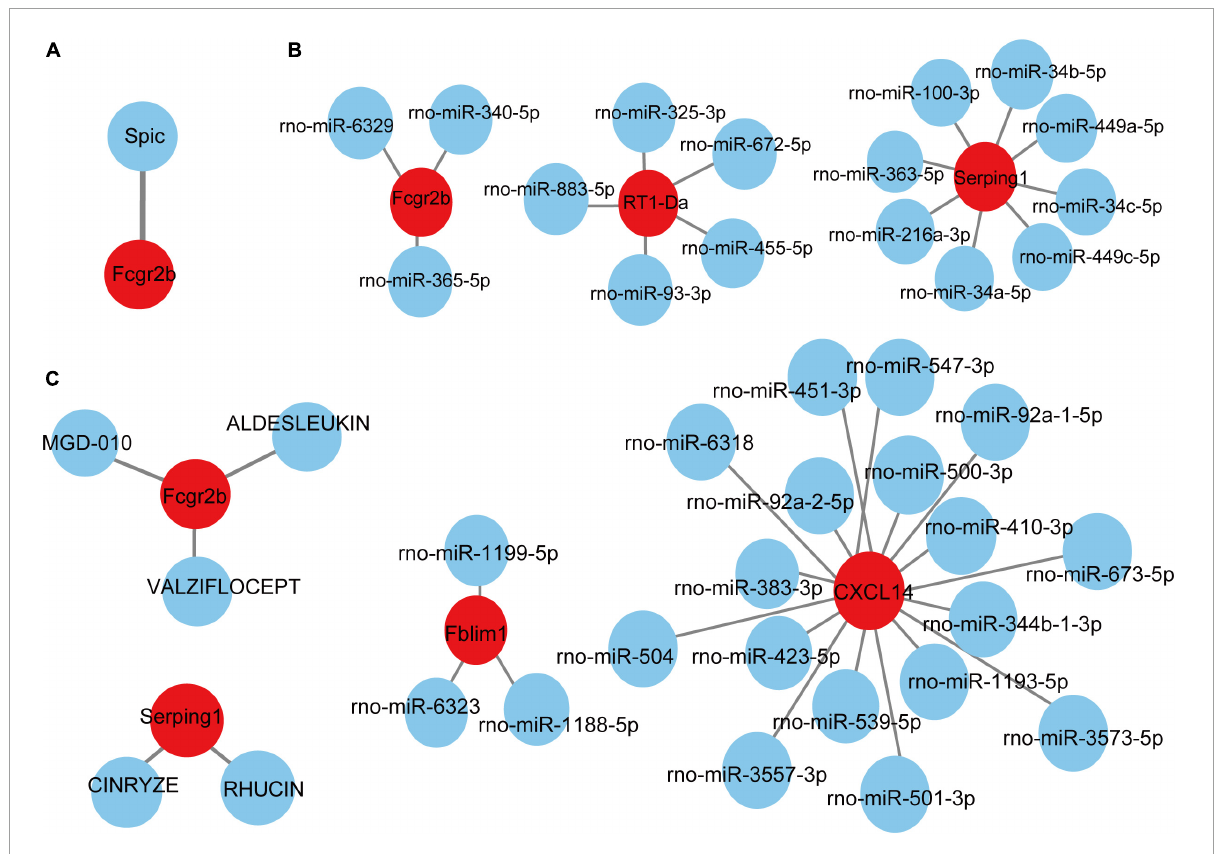
FIGURE7 TF-miRNA-drugs regulatory networks. (A) TF prediction for hub genes based on TRRUST database. (B) miRNA network prediction for hub genes based on miRDB database. (C) Drug-genes interaction network prediction. Red nodes represent hub genes. Blue nodes represent predicted TFs, miRNA or